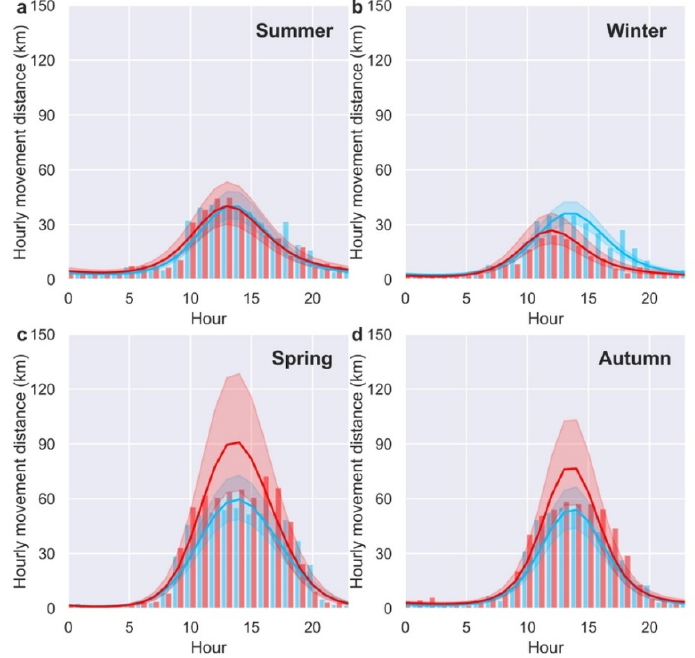
Figure 3. Maximum Hourly movement distances of American White Pelicans with circadian hours. Blue and red colors represent wintering groups at Northern and Southern Gulf of Mexico, respectively. Panels represent ( a ) summer, ( b ) winter, ( c ) spring migration, and ( d ) autumn migration. Bars show observed maximum hourly movement distances. Lines indicate the estimated maximum hourly movement distances based on the best model. Polygons represent 95% confidence intervals of the maximum hourly movement distances.